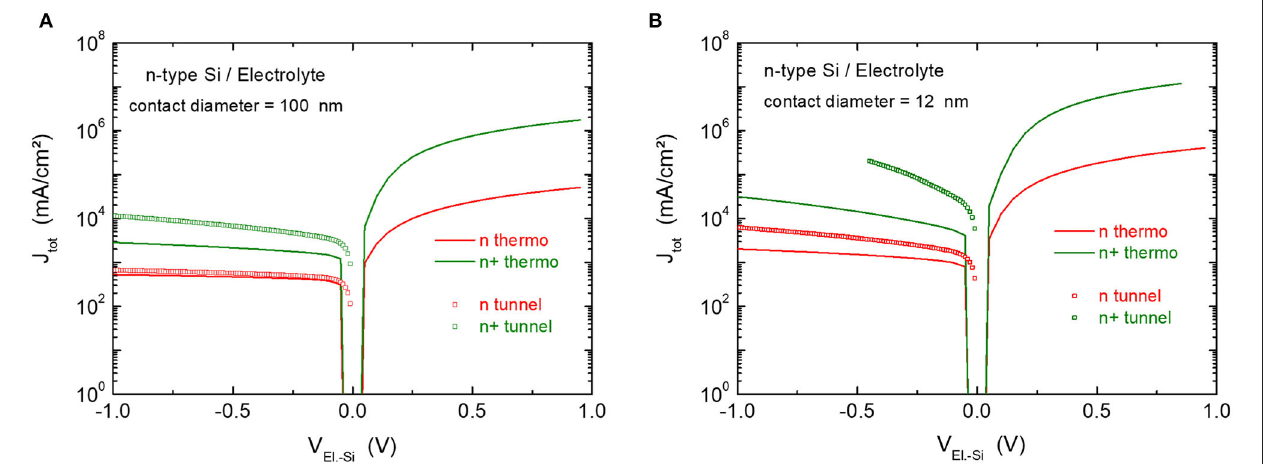
FIGURE 4 | I–V characteristics of n and n + silicon in contact with an HF electrolyte (W = 4.5eV). The electrolyte contact diameter is 100nm (A) and 12nm (B) . The current is calculated either for thermionic emission (including image potential effect), and with or without tunneling current